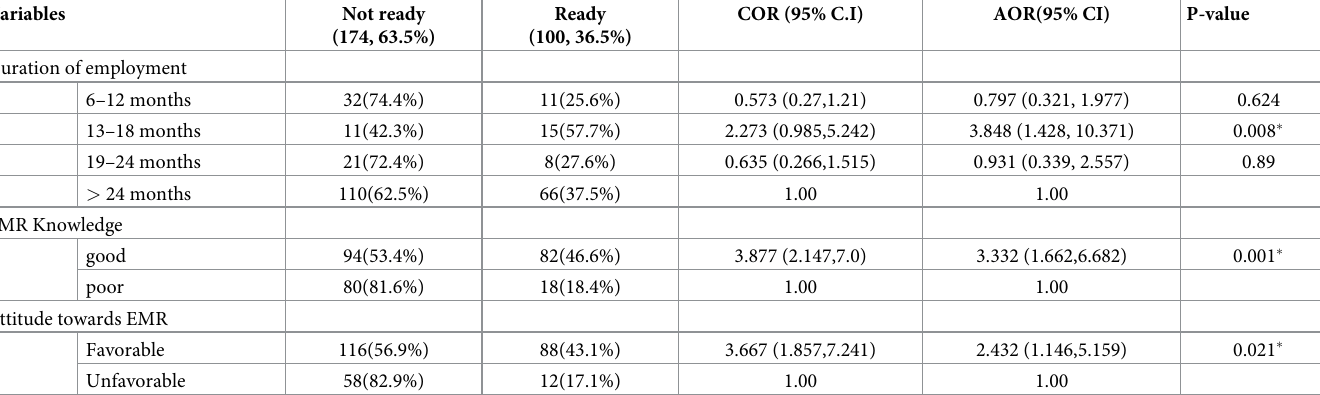
Table 3. Bivariable and multivariable analysis of factors associated with health professional readiness to implement EMR in public general hospitals of Sidama region, 2022.